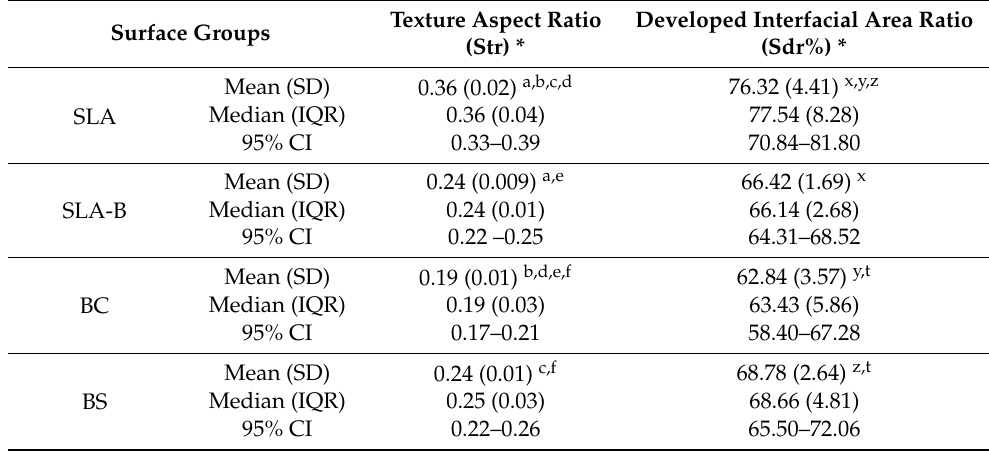
Figure 7. Box-and-whisker plots showing median and quartile values for the Str and Sdr% values. * represents outliers. Table 3. Spatial (Str) and hybrid (Sdr%) surface roughness values measured using